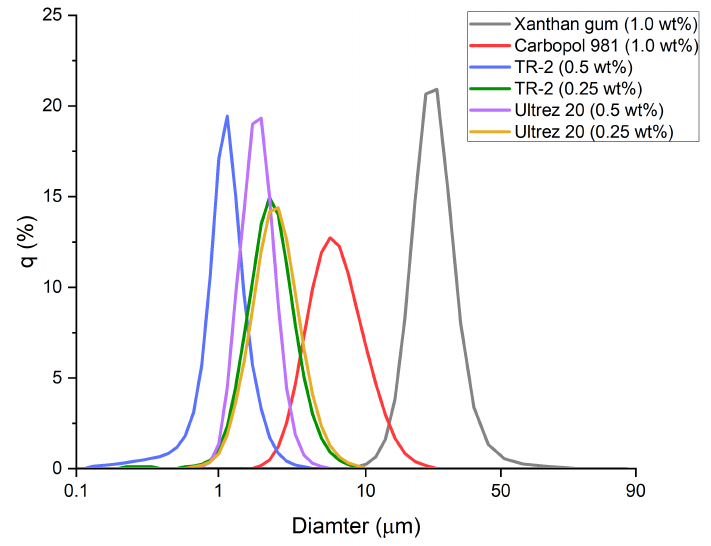
Figure 1. Particle size distribution of emulsions prepared with different gelling agents.